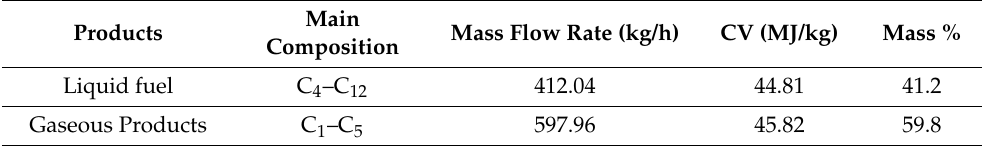
Table 6. Hydrocracking process products’ composition based on process simulation.